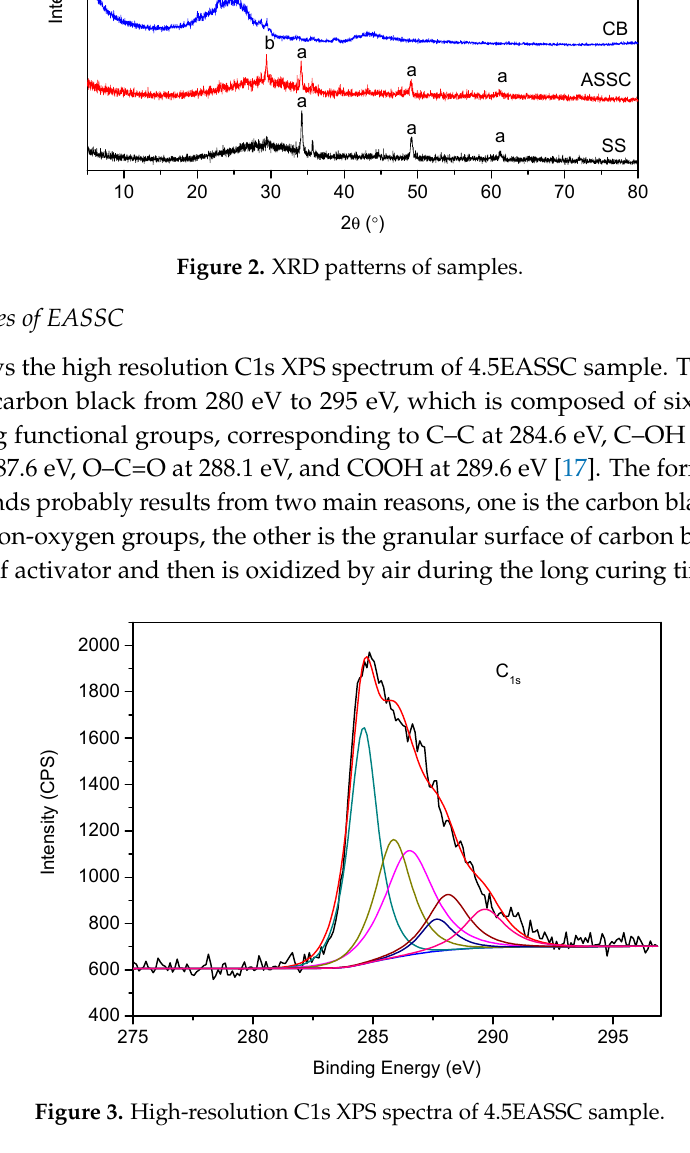
Figure 3. High-resolution C1s XPS spectra of 4.5EASSC sample.